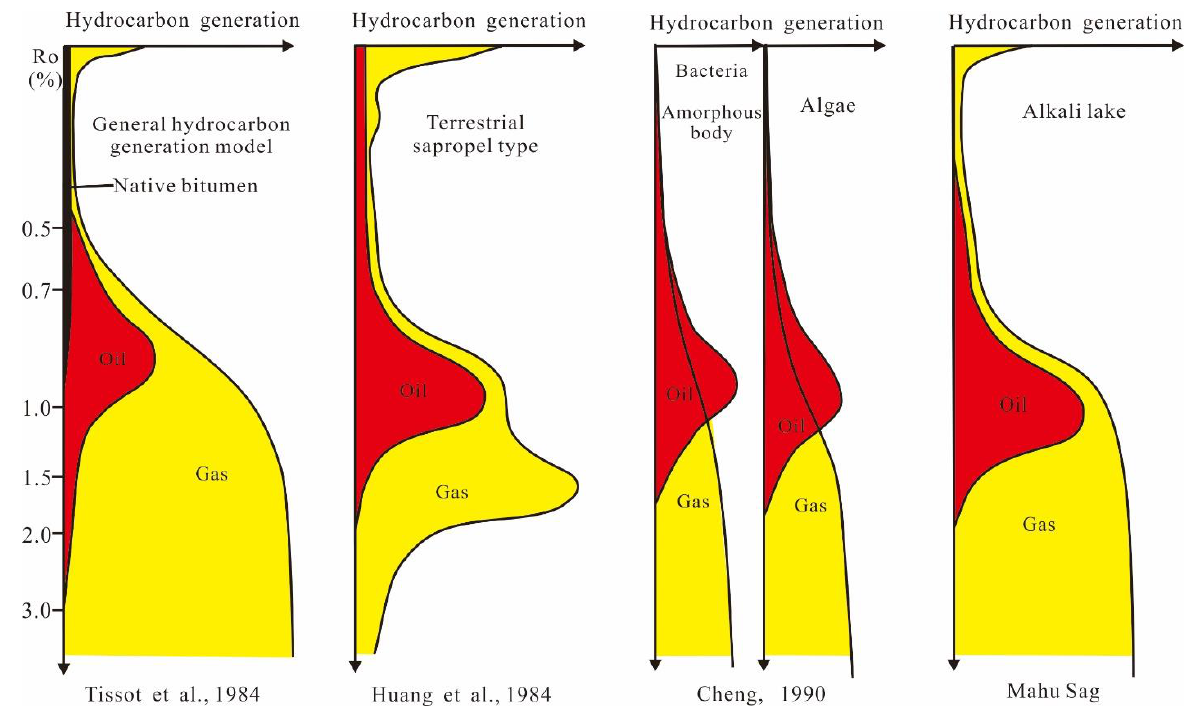
Figure 11. Comparison of hydrocarbon generation models between source rocks and alkaline lake source rocks in continental freshwater lake basins [36,42].